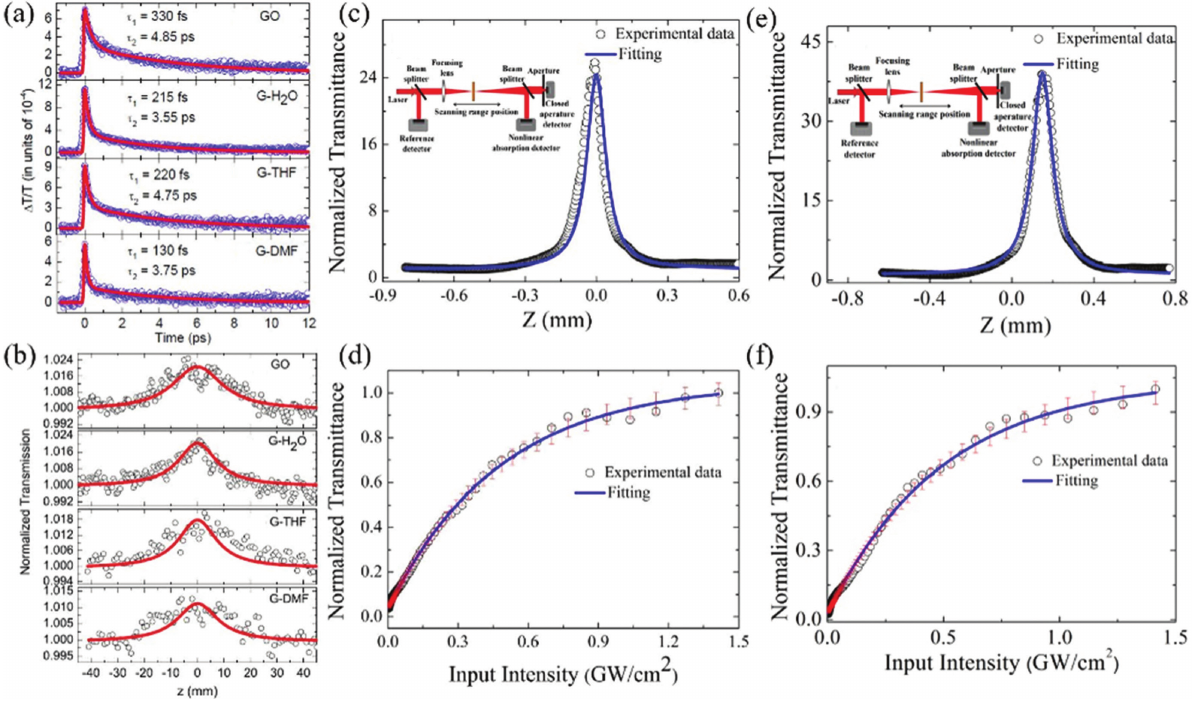
Figure 3: Nonlinear optical properties of graphene and TIs. (A,B) Graphene. (A) Transient differential transmission spectra for graphene suspensions as a function of probe delay in the degenerate pump- probe experiment at 790 nm (1.57 eV). (B) Open aperture Z-scan data of the graphene suspensions. Reproduced with permission from Ref. [11]. Copyright 2009, American Institute of Physics. (C,D) Bi Te . (C) Typical Z-scan peak curve of Bi Te at 1550 nm. Inset: Z-scan experimental setup. 2 3 2 3 (D) The corresponding nonlinear saturable absorption curve. Reproduced with permission from Ref. [15]. Copyright 2012, American Institute of Physics. (E,F) Bi Se . (E) Typical Z-scan peak curve of Bi Se at 1550 nm. Inset: Z-scan experimental setup. (F) The corresponding nonlinear 2 3 2 3 saturable absorption curve. Reproduced with permission from Ref. [16]. Copyright 2012, American Institute of